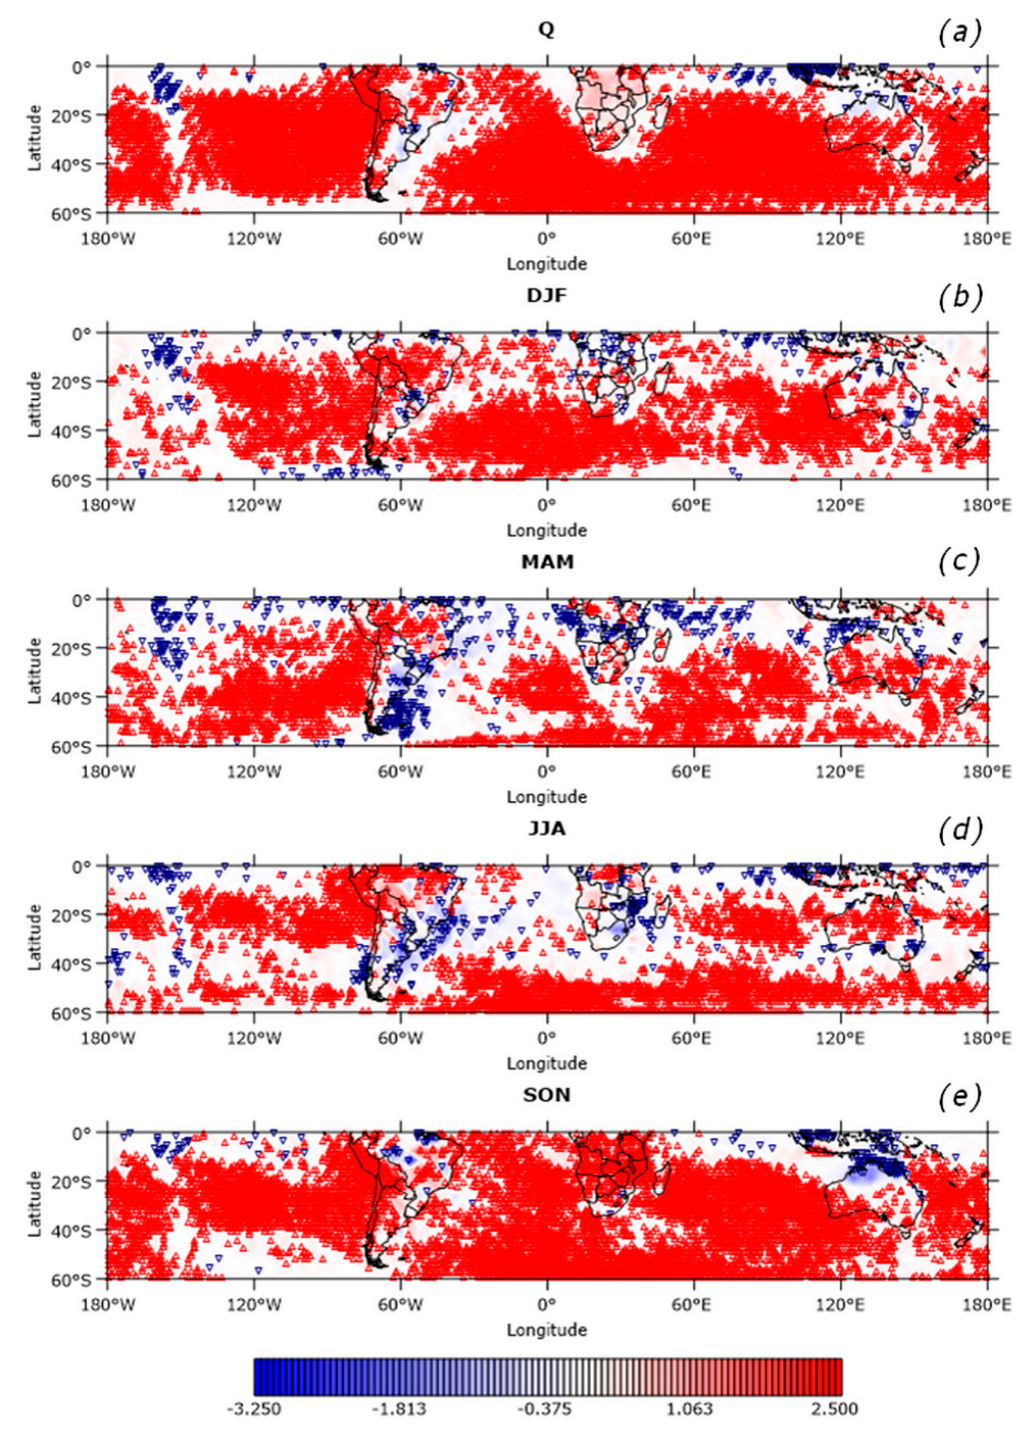
Figure 6. As in Figure 3 but for the seasonal concentrations of NO 2 in the troposphere (Trop). Q, DJF, MAM, JJA and SON figures are shown in panels ( a – e ), respectively.